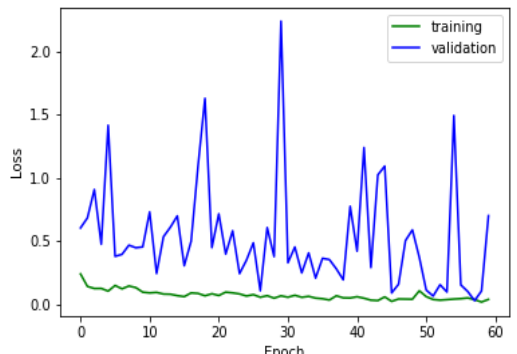
augmented with weighted contrast and brightened radiograph Images, validated on 16 images and tested on 624 radiograph images. Figure 6 (a-b) represents the training accuracy and training loss as well as validation accuracy and loss for the proposed model.